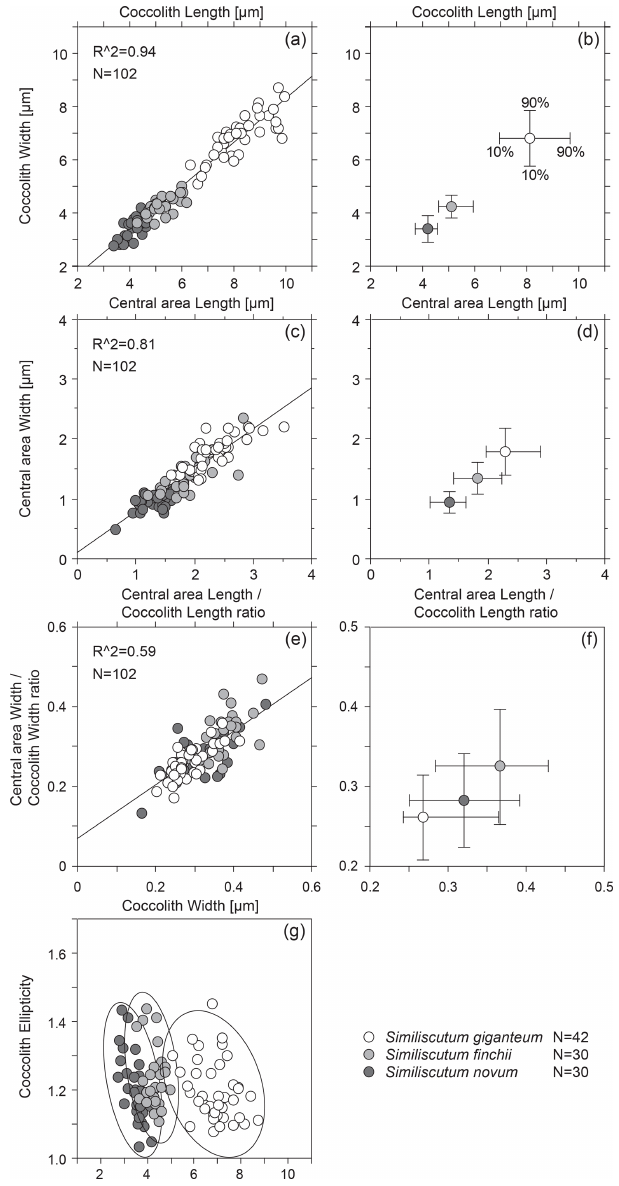
Figure 3. Bivariate plot of coccolith length and width (a) and of central-area length and width (c) . The calculated R 2 is quite high. Mean values with the 10th–90th percentiles of frequency distribu- tion for coccolith length and width (b) and for central-area length and width (d) for the three analysed species. Bivariate plot of the ratios “central-area length over coccolith length” and “central-area width over coccolith width” (e) and mean values with the 10th– 90th percentiles of frequency distribution for these two ratios (f) for the three analysed species. Coccolith ellipticity versus coccolith width (g) . N is the number of measured